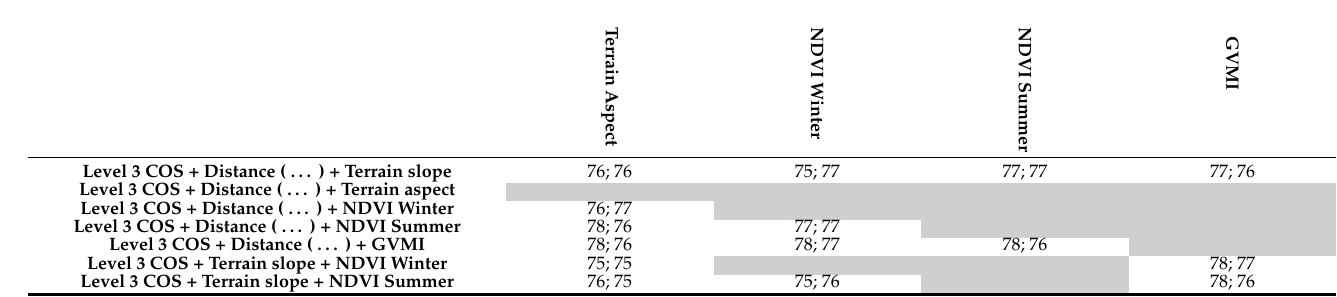
Table 13. Results of the modeling script combining groups of four environmental variables. The value before the semicolon represents the training AUC, while the value after represents the prediction AUC. T e rr a